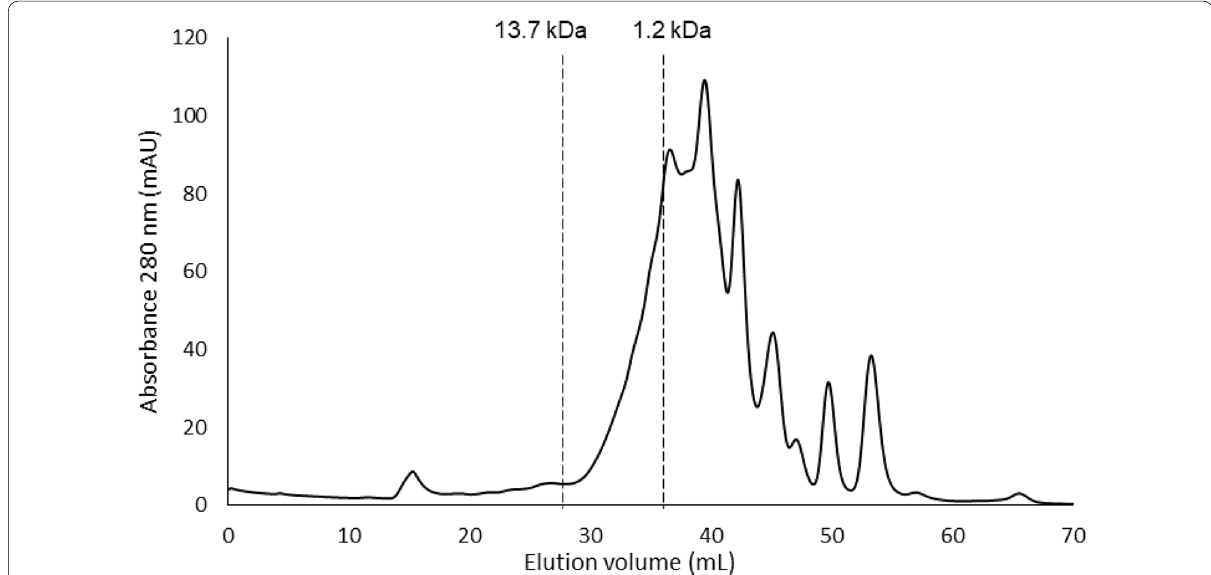
Fig. 2 Size-exclusion FPLC profile of porcine protein hydrolysates obtained upon hydrolyzing with alcalase. Molecular weight markers of 13.7 kDa and 1.2 kDa are indicated